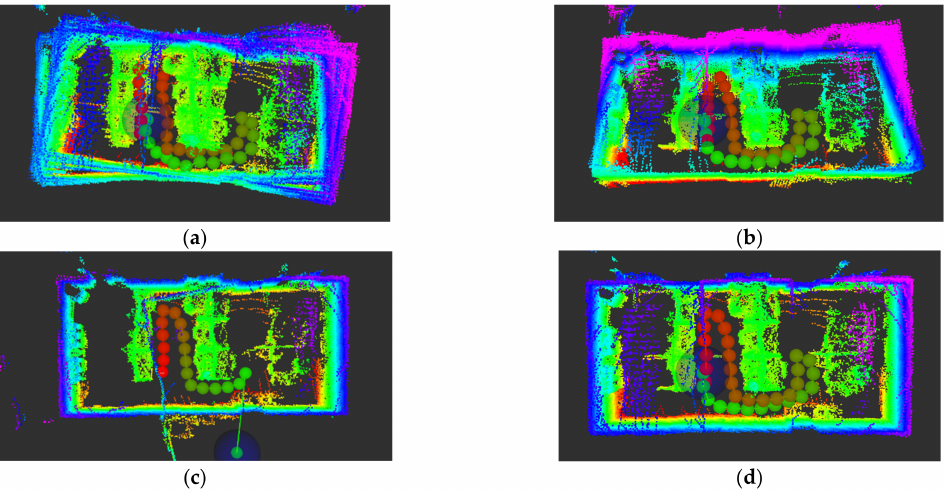
Figure 11. Drawing effect of four matching algorithms. ( a ) ICP-mapping, ( b ) GICP-mapping, ( c ) NDT-mapping, ( d ) NDT_OMP-mapping.